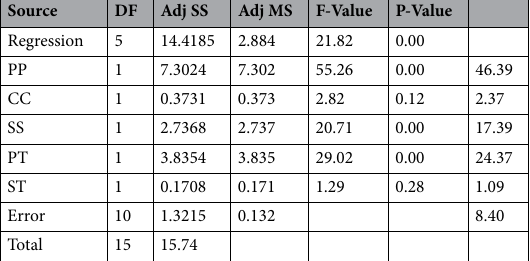
Table 8. Regression analysis of variance for the percentage elongation of hybrid